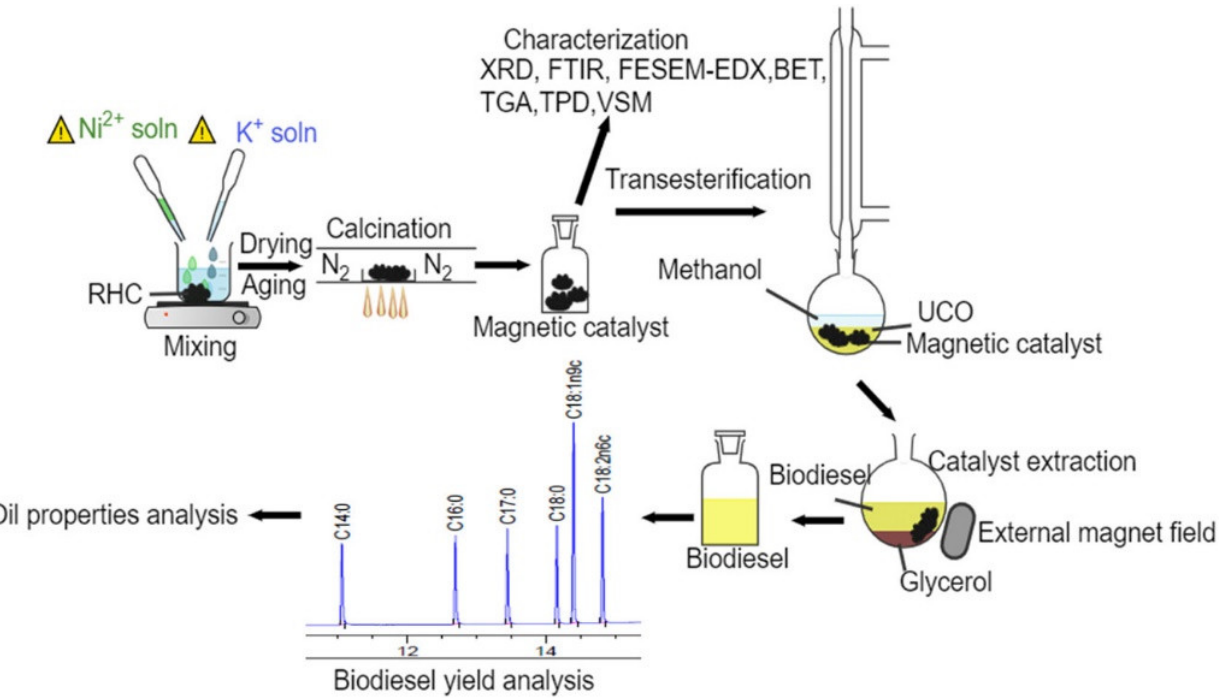
Figure 3. Bifunctional alkali (K)/metal (Ni) biochar-supported catalyst from rice husk for the transesterification of cooking oil. With permission from [44].